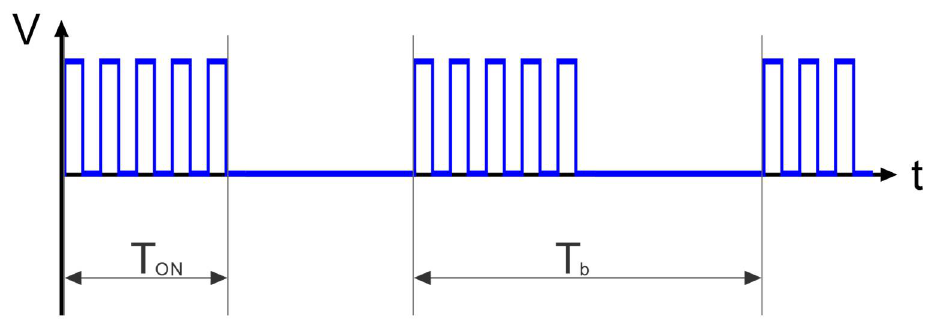
Figure 7. Actuation burst-type signal applied to the PZT plates.